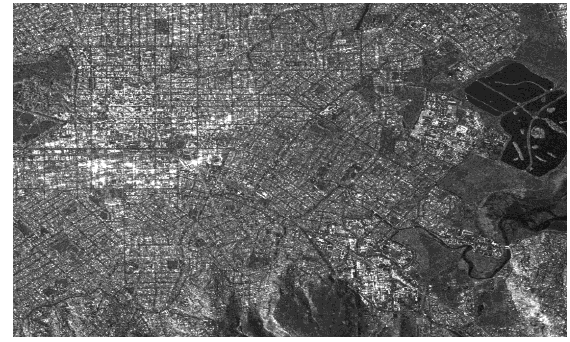
Figure 2. Average amplitude image of Christchurch after the earthquake of 22 February